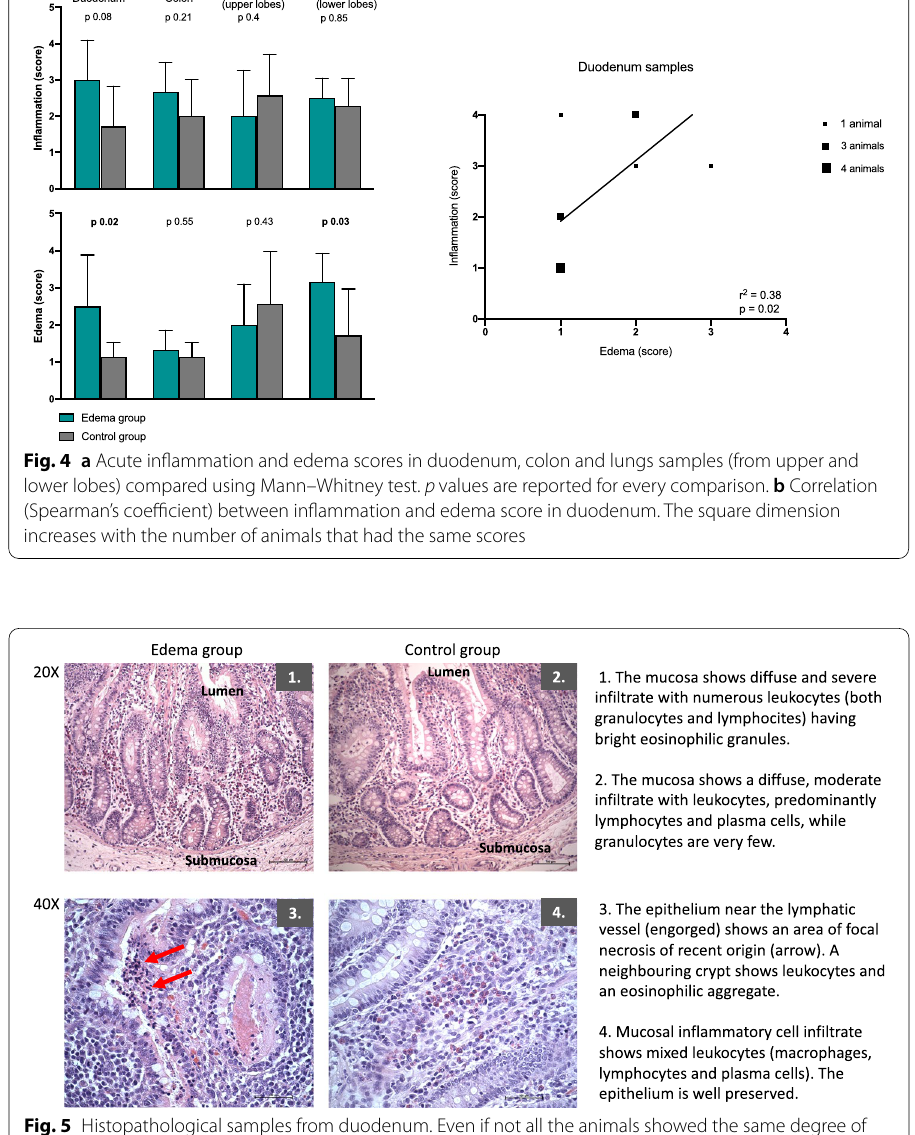
TNFα concentration correlated with IAP in the lower lung lobes ( p < 0.05); r 2 was 0.28 in the colon and 0.24 in ascites. TNFα correlated with MAP in the upper lung lobes and the colon. No other correla- tion between inflammation markers and hemodynamic parameters was identified.